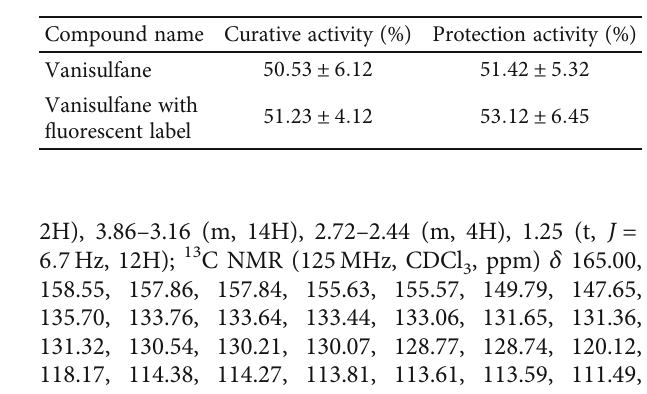
Figure 4: Fluorescence intensity of vanisulfane fl uorescent label compounds in di ff erent solvents. Table 2: The anti-CMV activity of vanisulfane and vanisulfane with fl uorescent label.